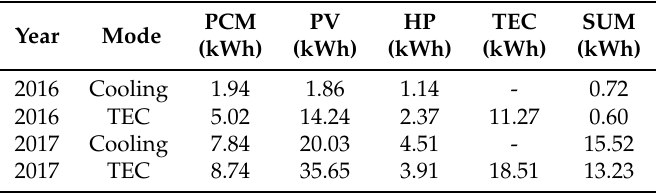
Table 1. Energy balance of the modes used in 2016 and